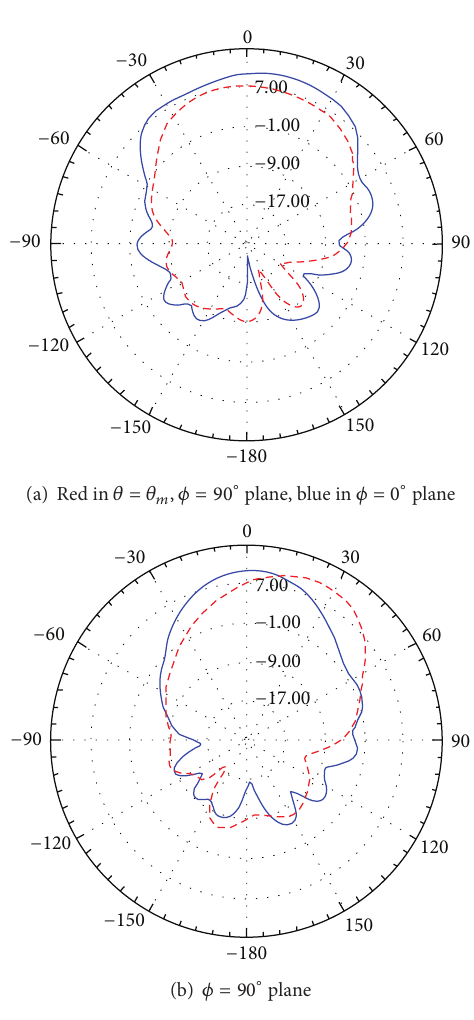
Figure 14: Step-cut simulated gain patterns, with initial step-cut results shown in red (dashed) and proposed design results in